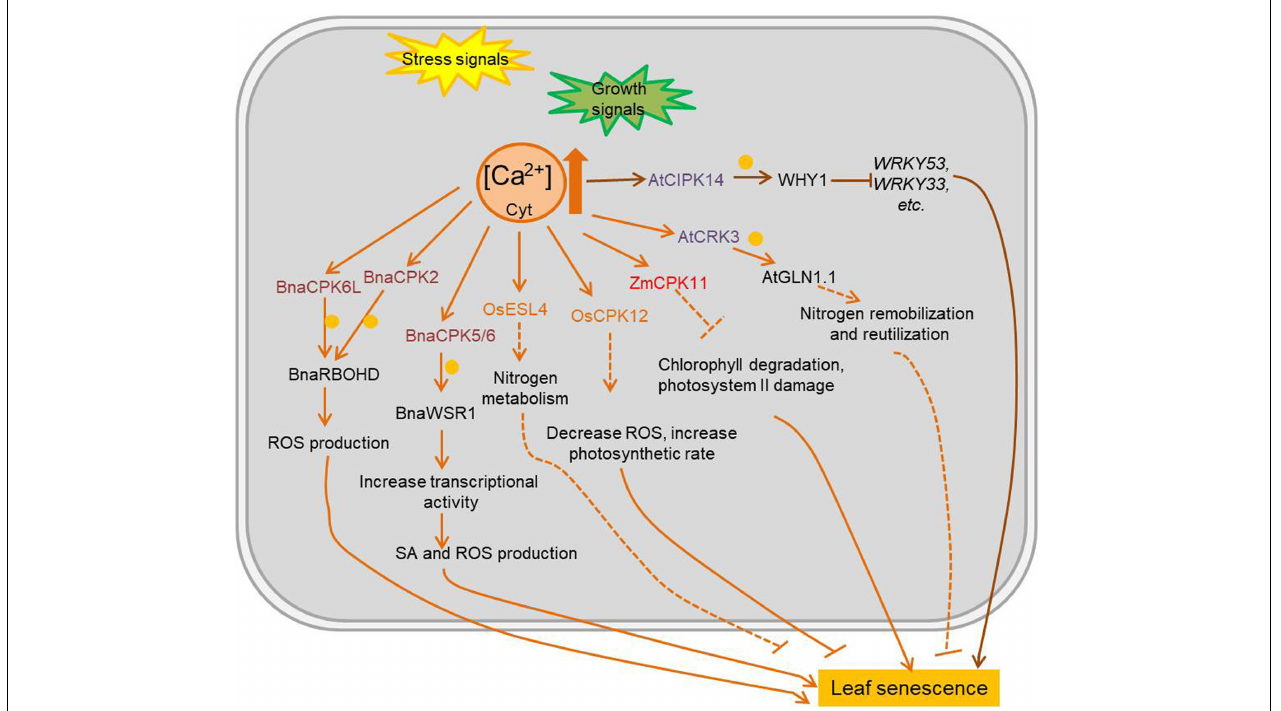
FIGURE 3 | Ca 2 + mediated plant leaf senescence in different conditions. Intracellular Ca 2 + change rapidly during plant development and stress response, and it always acts as second messenger to activate Ca 2 + sensing proteins. The kinases which are regulated by levels of Ca 2 + and function in leaf senescence are marked in colors. Arrows show that the process is promoted, and T-bars mean the process is inhibited; blue circles indicate phosphorylation; solid lines indicate the direct reported relationship, and dotted lines indicate indirect reported relationship. CPKs/CDPKs, calcium-dependent protein kinases; CIPKs, CBL-interacting protein kinases; CBL, calcineurin B-like proteins; OsESL4, O. sativa early senescent leaf 4; AtCRK3, Arabidopsis thaliana CDPK-related kinase 3; BnaWSR1, B. napus WRKY regulating SA and ROS 1; AtGSR1, Arabidopsis thaliana glutamine synthase clone R 1; WHY1, WHIRLY1; JA, jasmonic acid; SA, salicylic